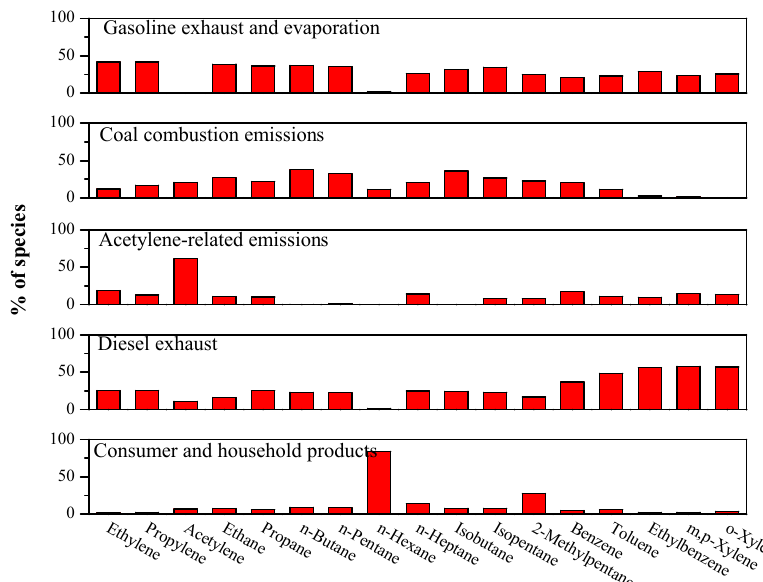
Figure 6. Source profiles (percentage of factor total) resolved from PMF in